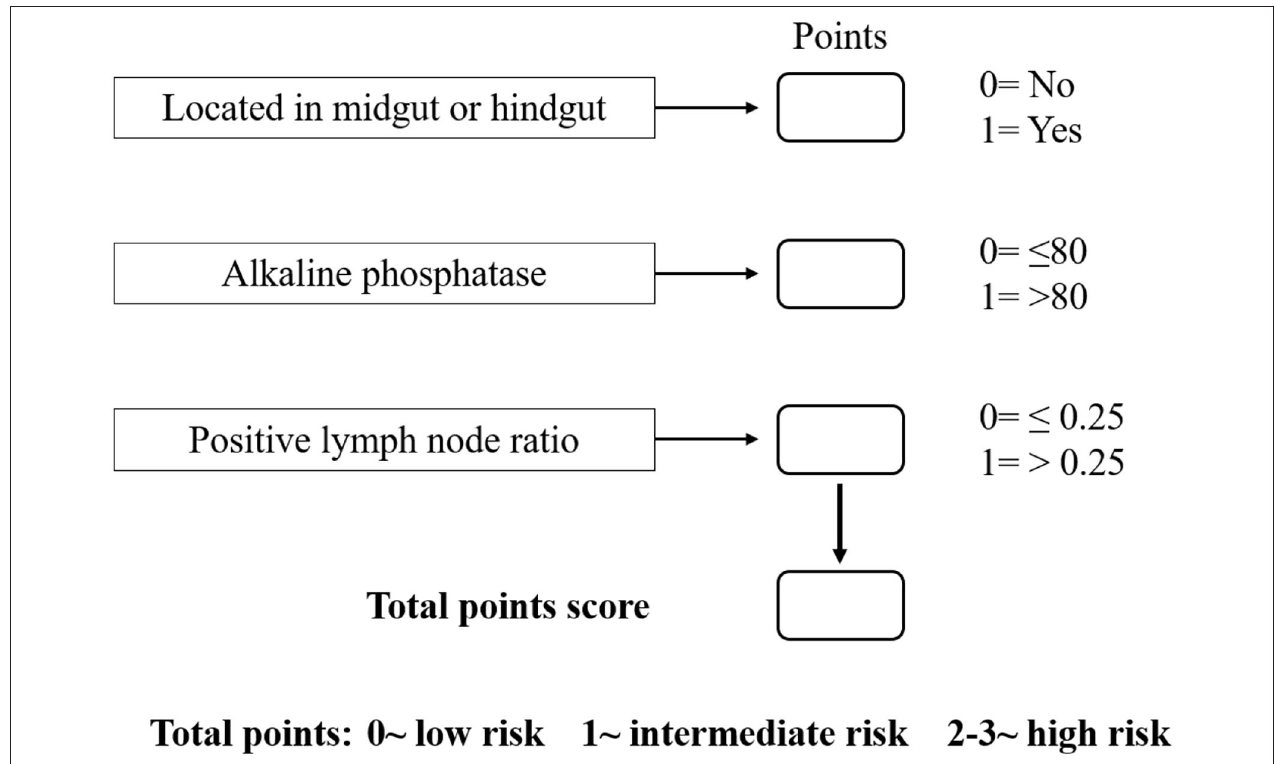
FIGURE 2 | Risk scoring model for early recurrence of